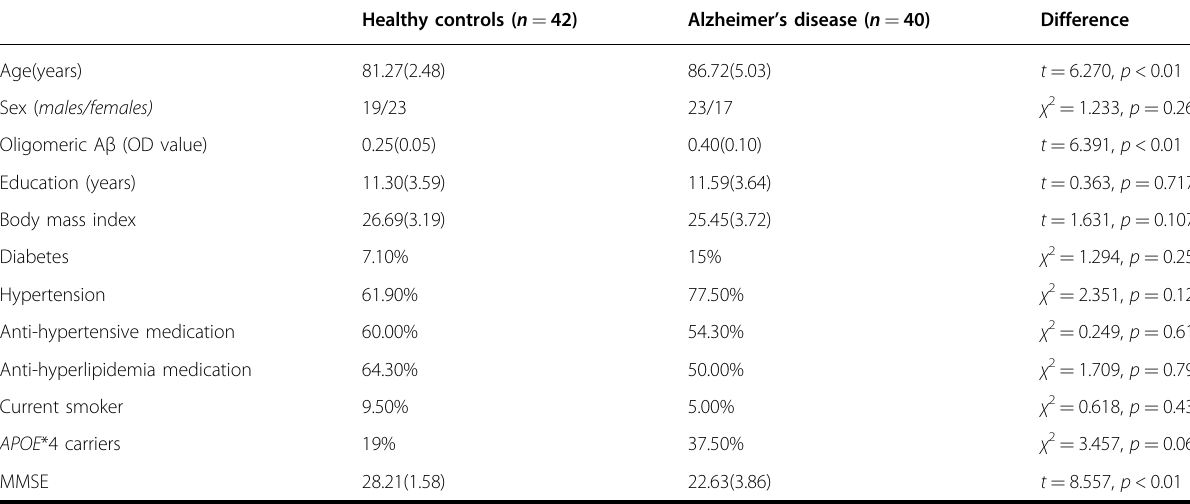
Table 1 Characteristics of Alzheimer ’ s disease and control